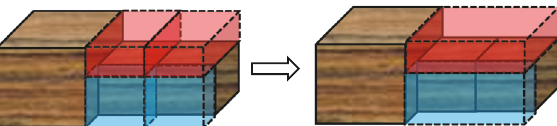
Figure 3: Y-Z-X division mode.